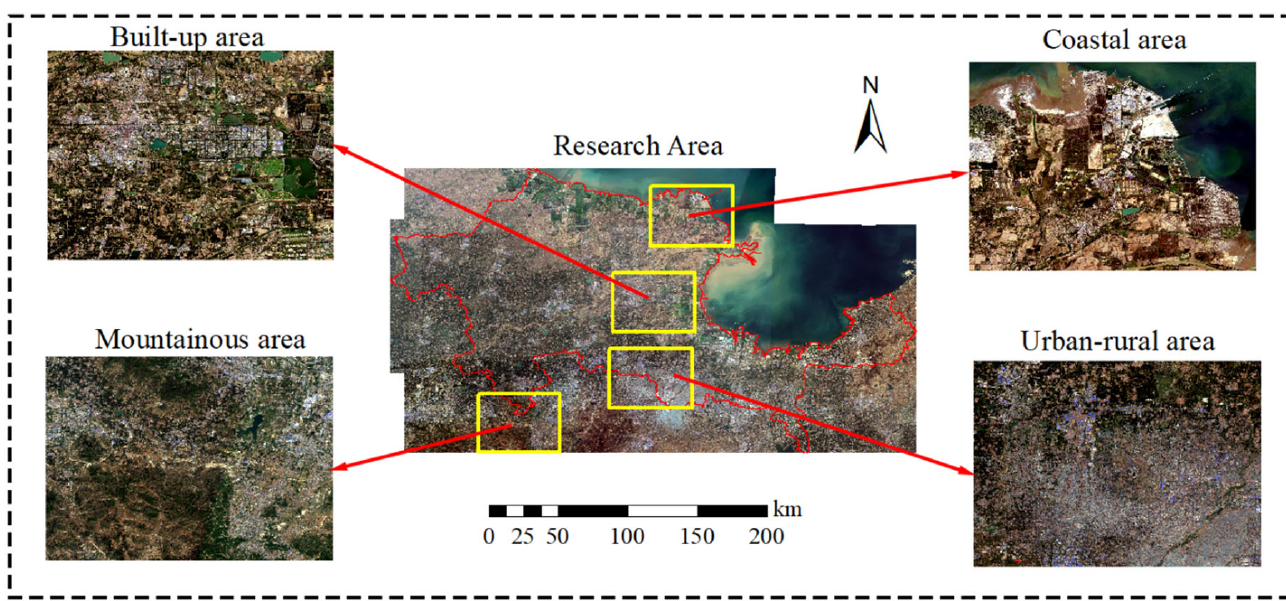
Figure 4. Sample selection area.